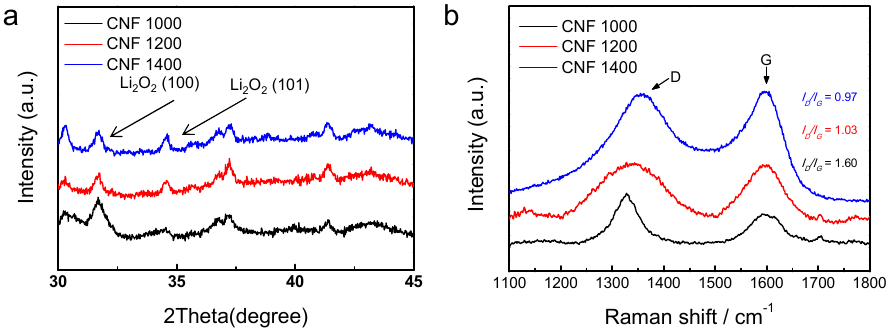
Figure 5. Analysis of CNF 1000, 1200 and 1400 after the discharging ( a ) XRD patterns ( b ) Raman results.